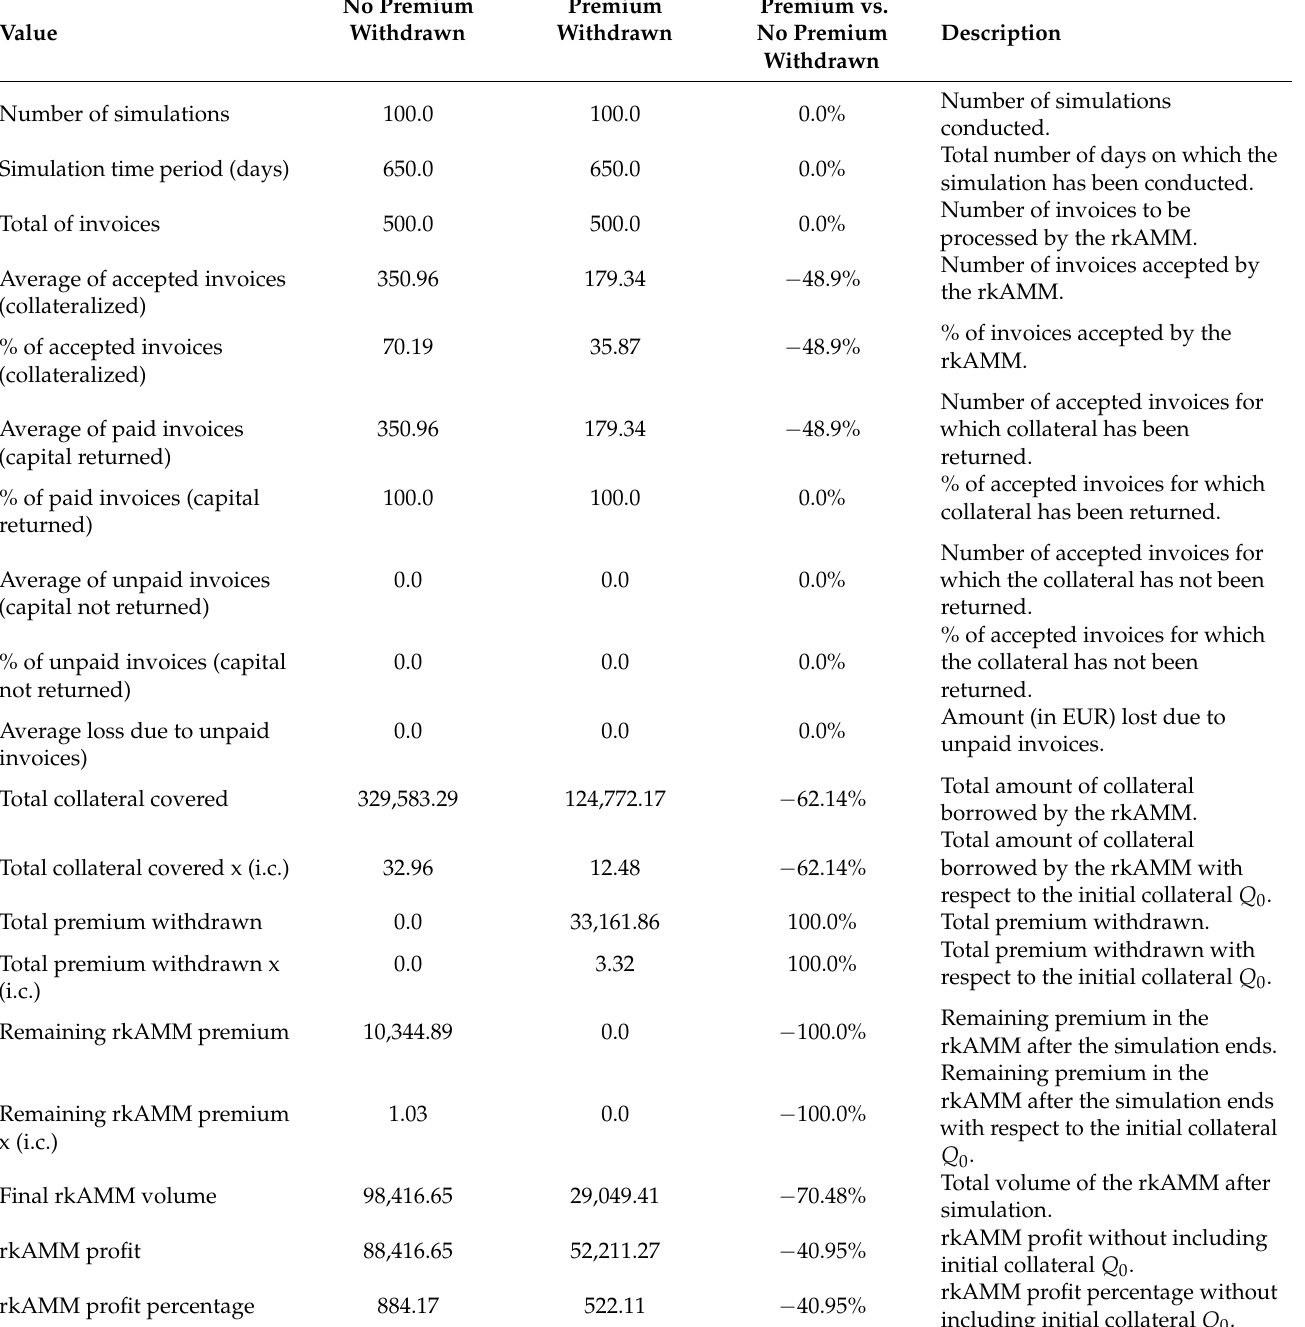
Table 8. Baseline scenario output. Scenario 5 and 30 days of withdrawal